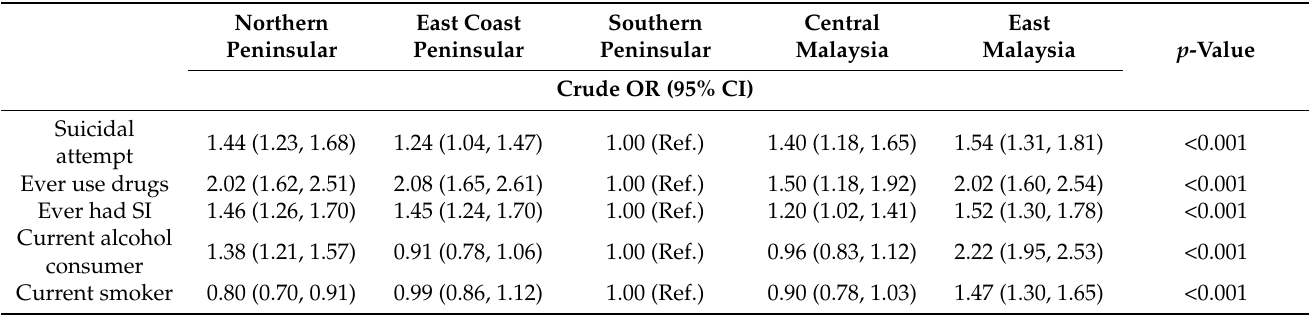
Table 2. Regression analysis to determine the strength of associations between selected high-risk behaviors and established topographical zones in